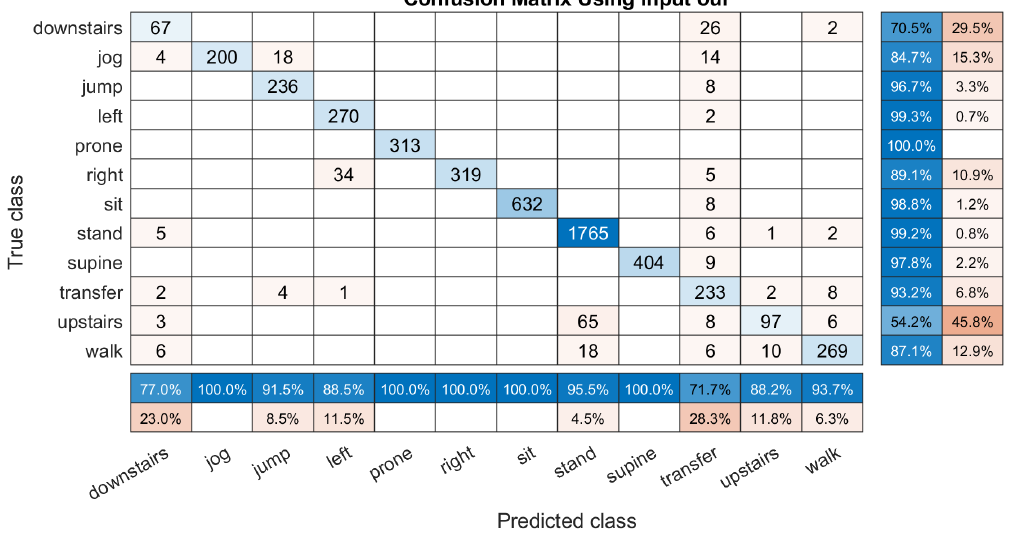
Figure 9. An example of the confusion matrix computed based on our input ˜ s ∗ = { s α 1 , s α 2 , s β 1 , s δ It have a column summary and row summary to display the accuracy and the errors of each